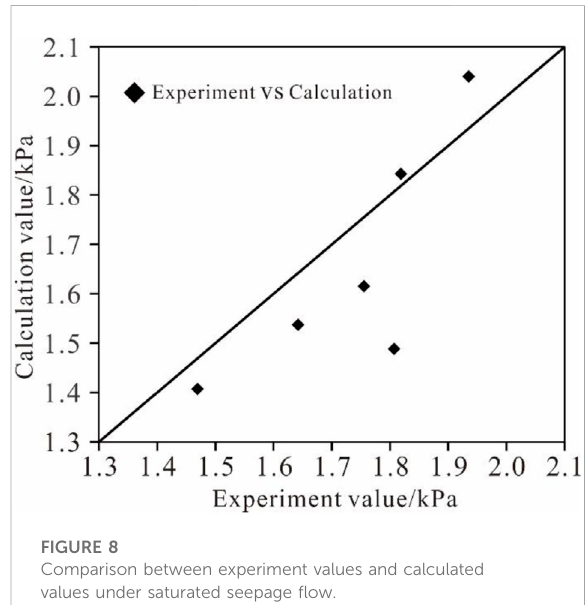
FIGURE 8 Comparison between experiment values and calculated values under saturated seepage fl ow.